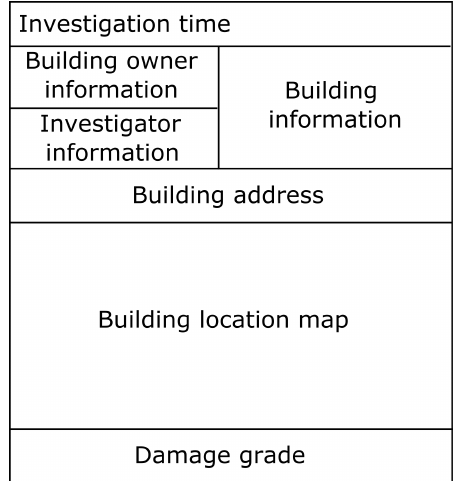
Figure 4. Simplified recording